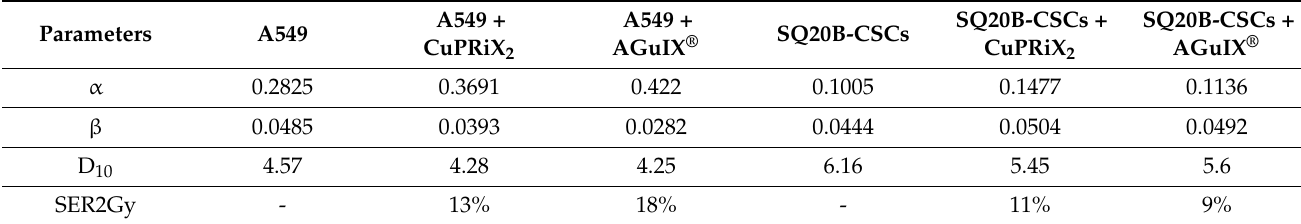
Figure 5. Radiosensitizing effect of AGuIX ® (800 µ M of DOTAGA(Gd)) and CuPRiX 2 (800 µ M of DOTAGA(Gd) and 500 µ M of uncomplexed DOTAGA) on ( a ) A549 and ( b ) SQ20B-CSCs cell lines. Both cell lines were treated with 800 µ M of Gd. Each curve is the mean of 3 independent experiments. Table 2. Summary of radiosensitizing parameters, D 10 and SER 2Gy.